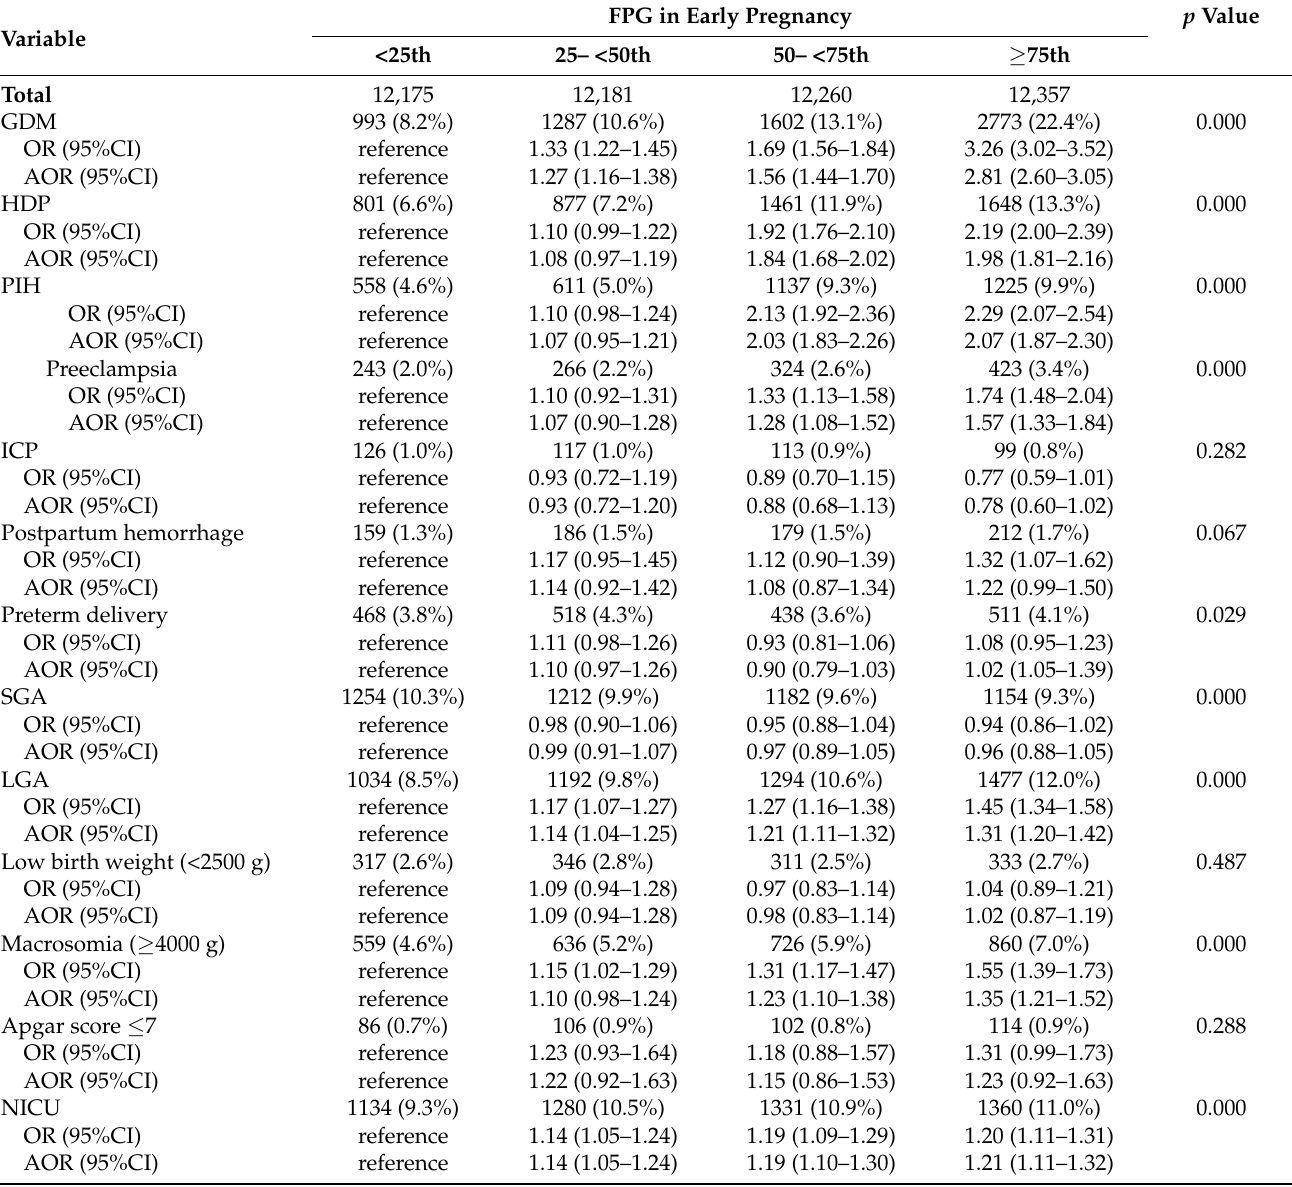
Table 2. Maternal FPG in early pregnancy categories and the risks of pregnancy